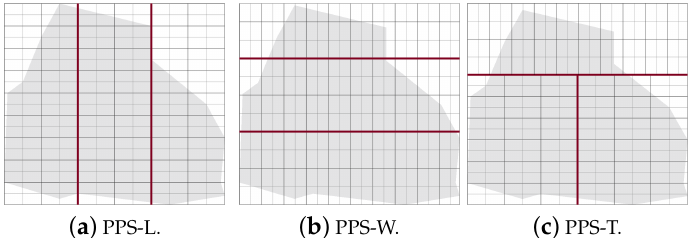
Figure 12. Examples of area partition using the three methods PPS-L, PPS-W and PPS-T.